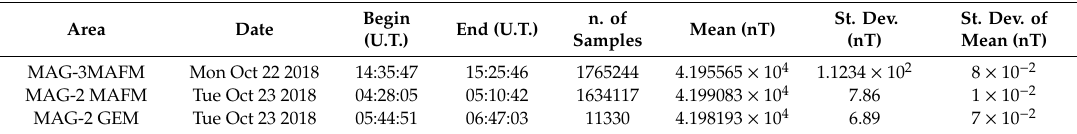
Table 8. Summary of the results of the gross statistical analysis performed on magnetic data in MAG-3 and